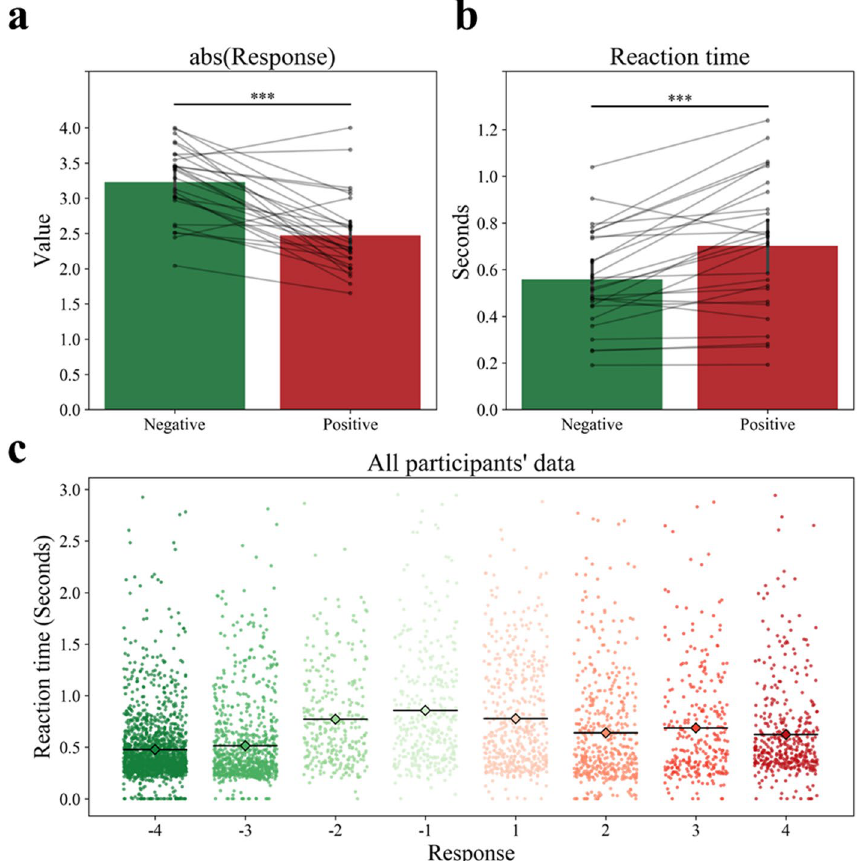
Figure 4. Comparison of positive and negative responses with respect to ( a ) absolute values of response and ( b , c ) reaction time. Black lines indicate each participant’s mean response value (a total of 27 participants; see in the text how response value was determined). An asterisk indicates a significant difference between two groups ( ps < 0.001). ( a ) Higher absolute response values represent that participants either more strongly accept ( Positive ) or deny ( Negative ) a given brand extension sample. ( b ) The reaction time (RT) was measured in second. ( c ) All participants’ data was aggregated and plotted with random jittering. Diamond with black line indicate mean of reaction time for each response